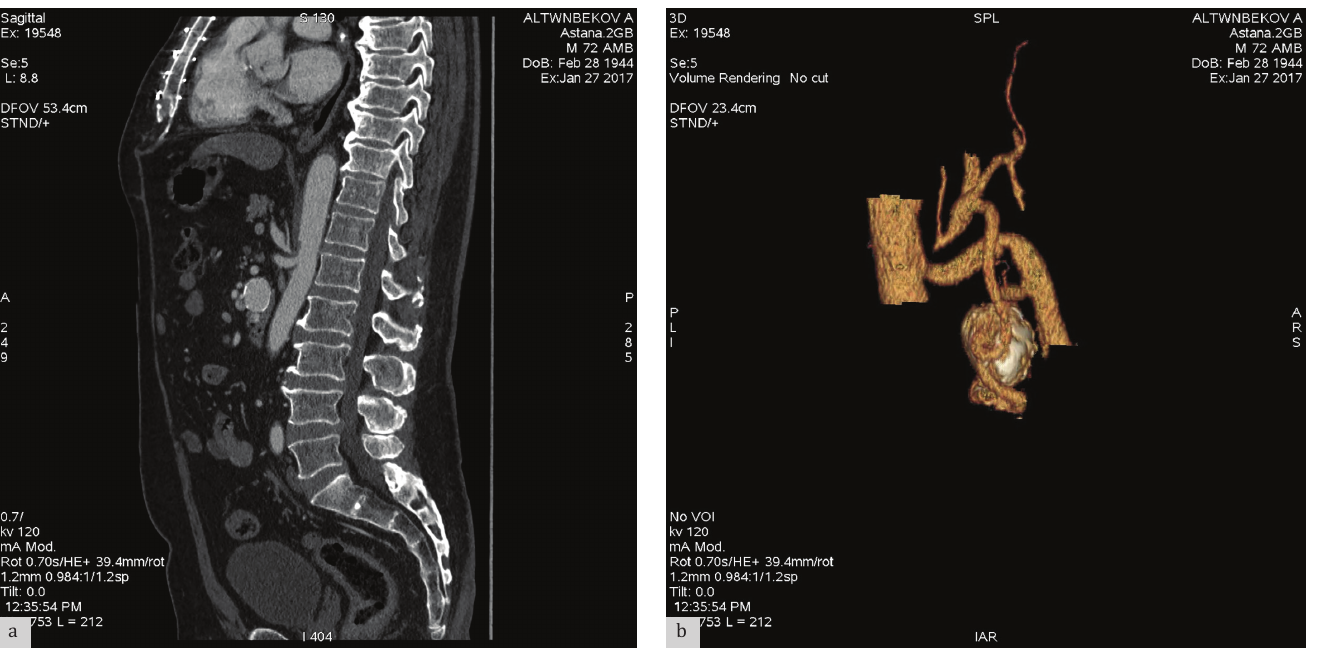
Figure 2 - Coronary angiography has shown the filiform stenosis of the celiac artery up to 1.5mm in diameter (a, b – vertical yellow arrow) and pancreaticoduodenal artery aneurysm with the size of 25,5 x 31,0 x 28,5 mm (horizontal blue arrow) with calcifications of its wall (blue